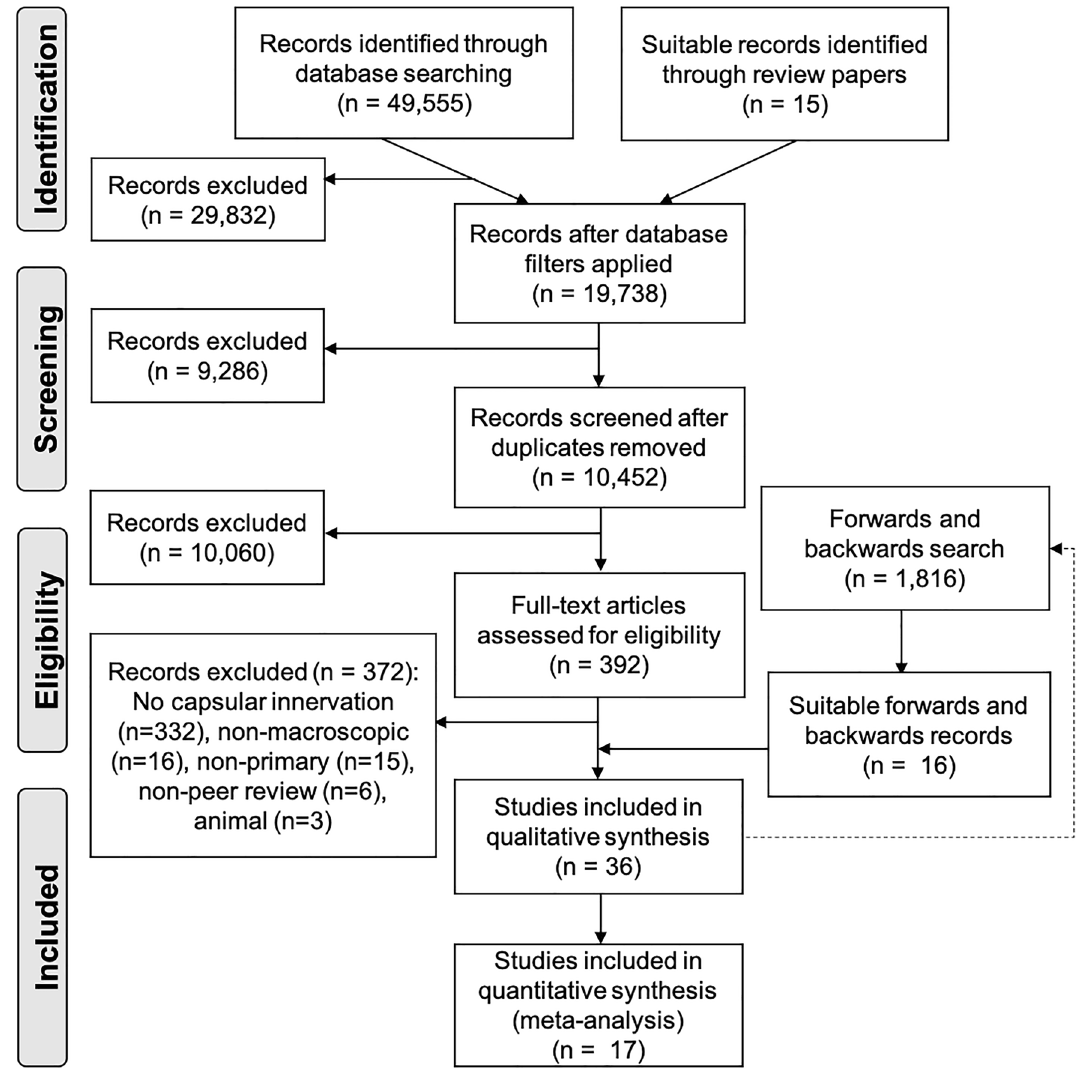
Figure 1. PRISMA flow chart displaying the search results based on Moher et al.(2010) 22 . The dotted line represents the articles located from the search of the databases undergoing forwards and backwards chain sampling to located further